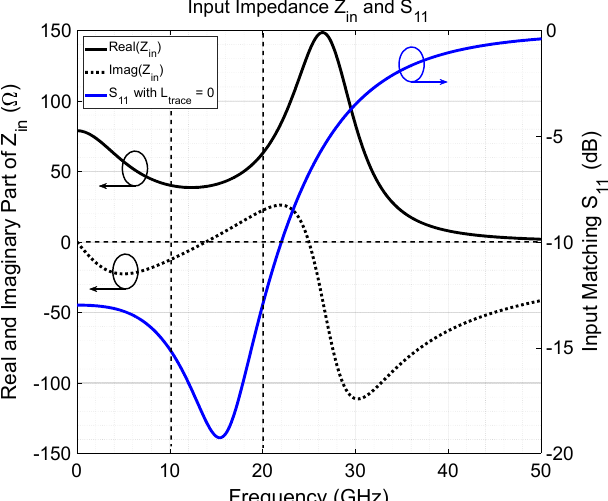
Figure 10. Input impedance and matching at the source.